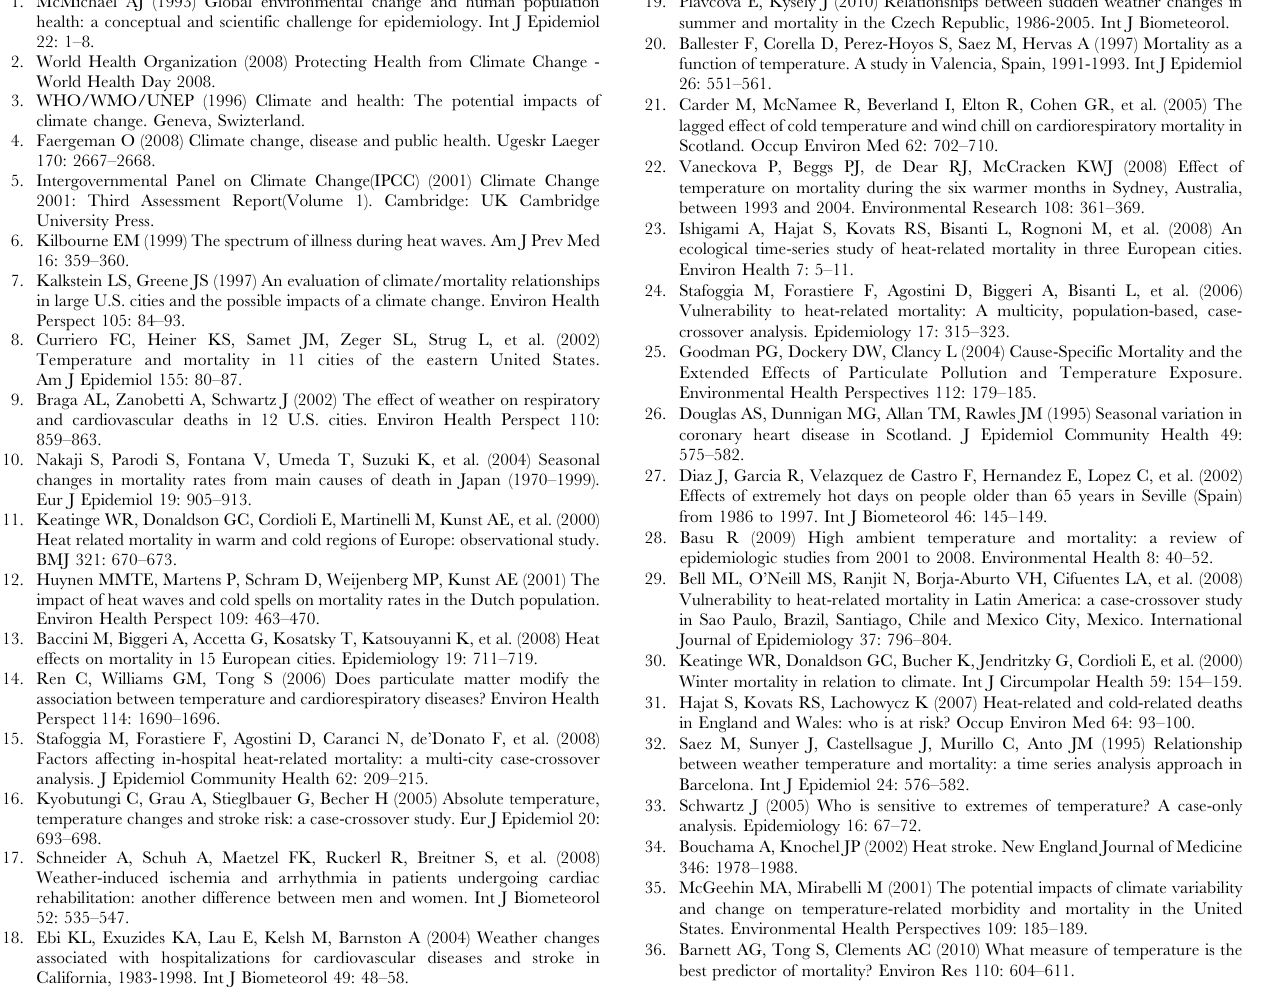
Figure 4. Bivariate response surfaces of the temperature change and mean temperature for non-external mortality, subgroups of mortality using model (3) in Los Angeles, United